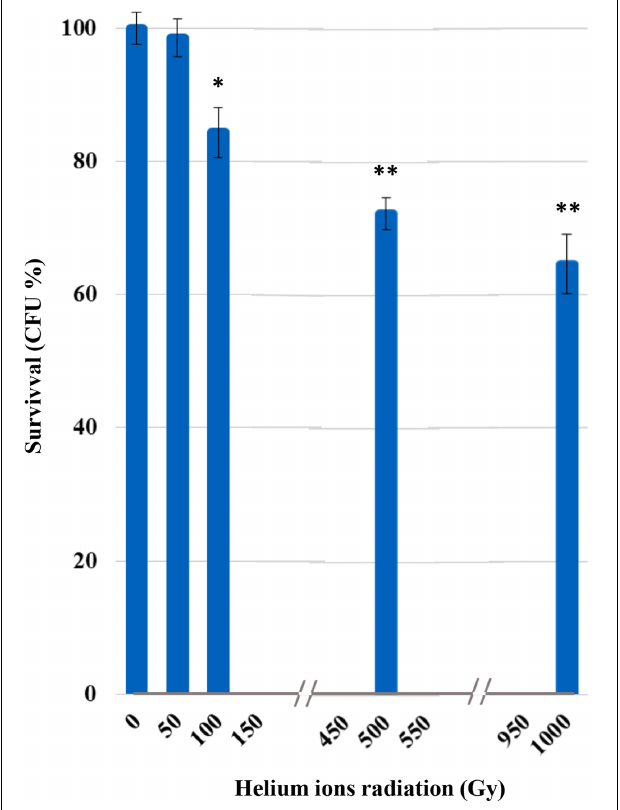
FIGURE 1 | Cultivation test after helium ions radiation: percentages of Cryomyces antarcticus CFU after 50, 100, 500, and 1,000 Gy. Data were normalized with the control. Significant differences were calculated by Tukey test with ∗ p > 0.05; and ∗∗ p > 0.001.